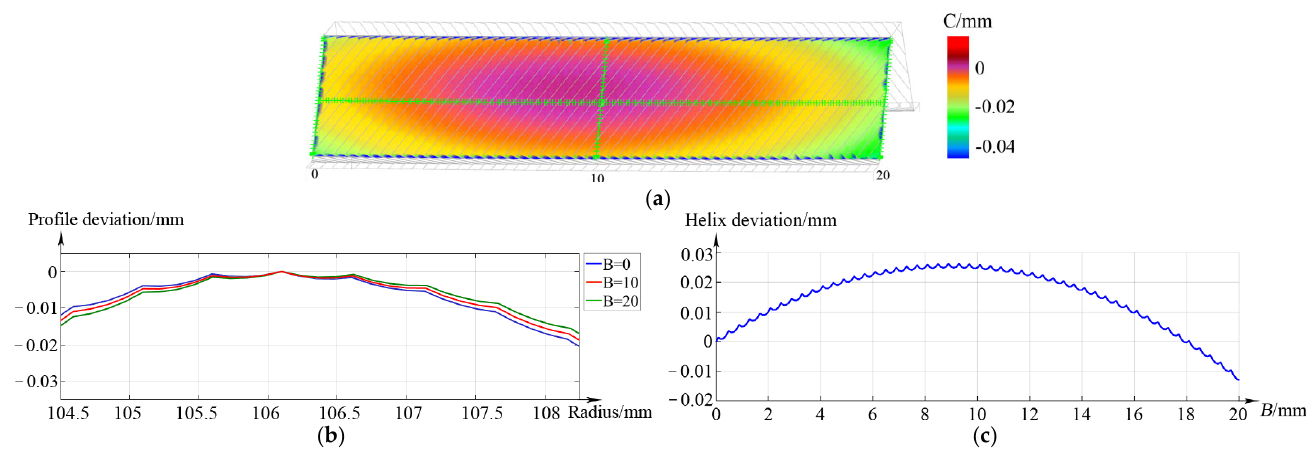
Figure 8. Measured deviations of the tooth flank enveloped via alterable shaft angle skiving method. ( a ) deviation contour plot, ( b ) profile deviation, ( c ) helix deviation.